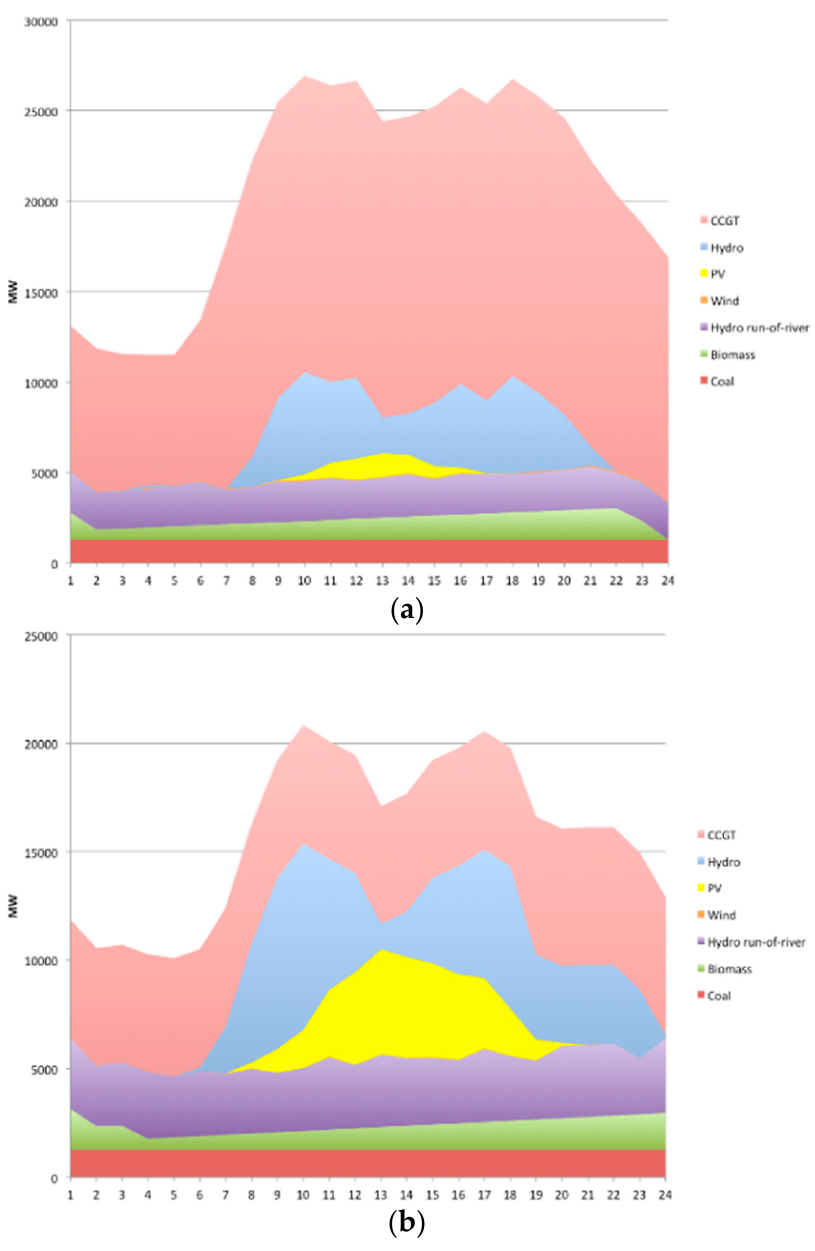
Figure 4. Generation profile NORD ( a ) NORD winter ( b ) summer.